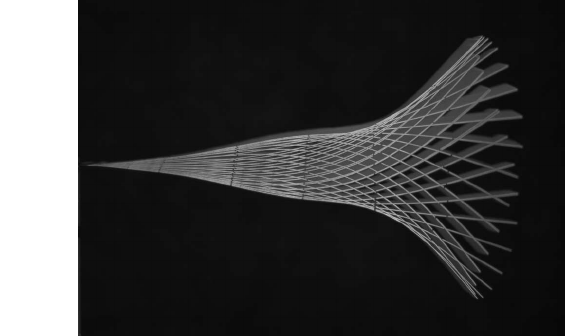
( j ) 32 cm flag experimental.